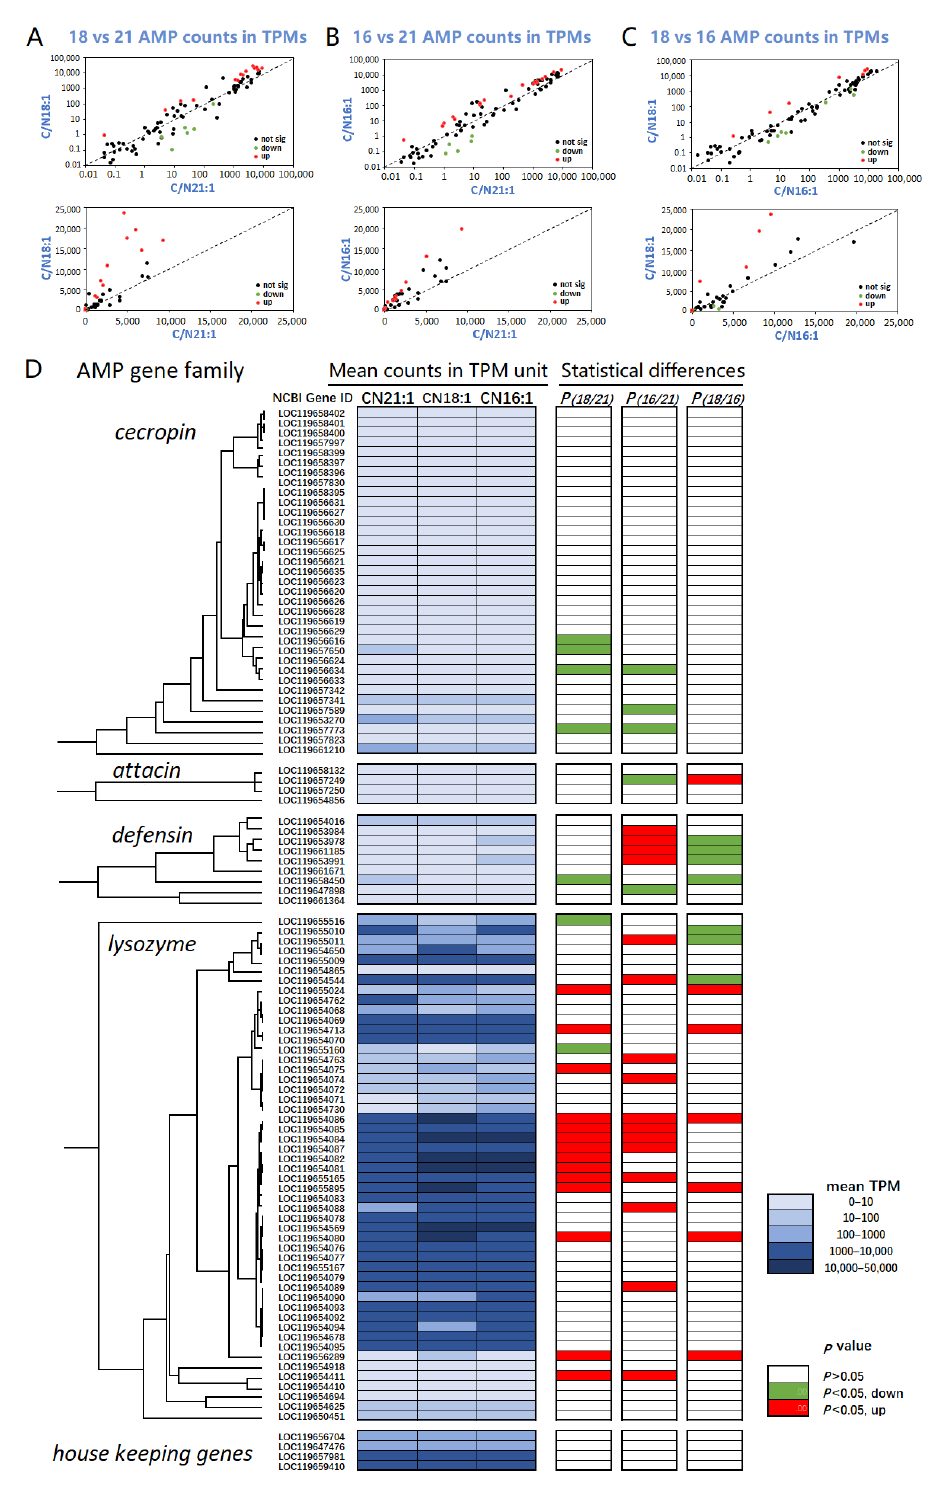
Figure 6. The transcriptome profiling of AMP gene family among larvae reared in the C/N 21:1, 18:1, and 16:1 conditions. ( A – C ), the correlations of transcript abundance in terms of TPMs; axes were represented in log scale and linear scale, respectively; significantly regulated genes ( p < 0.05) were marked in red (up) or green (down) color. ( D ), the expression analysis of the AMP gene family; evolutionary trees of AMP gene family were presented; average expression levels in TPM units were displayed in blue color scale, and statistical differences of C/N 18:1 vs. 21:1, C/N 16:1 vs. 21:1, and C/N 18:1 vs. 16:1 were shown in the red (up-regulated) or green (down-regulated) color, being consistent with the dot colors in the graph ( A – C ).